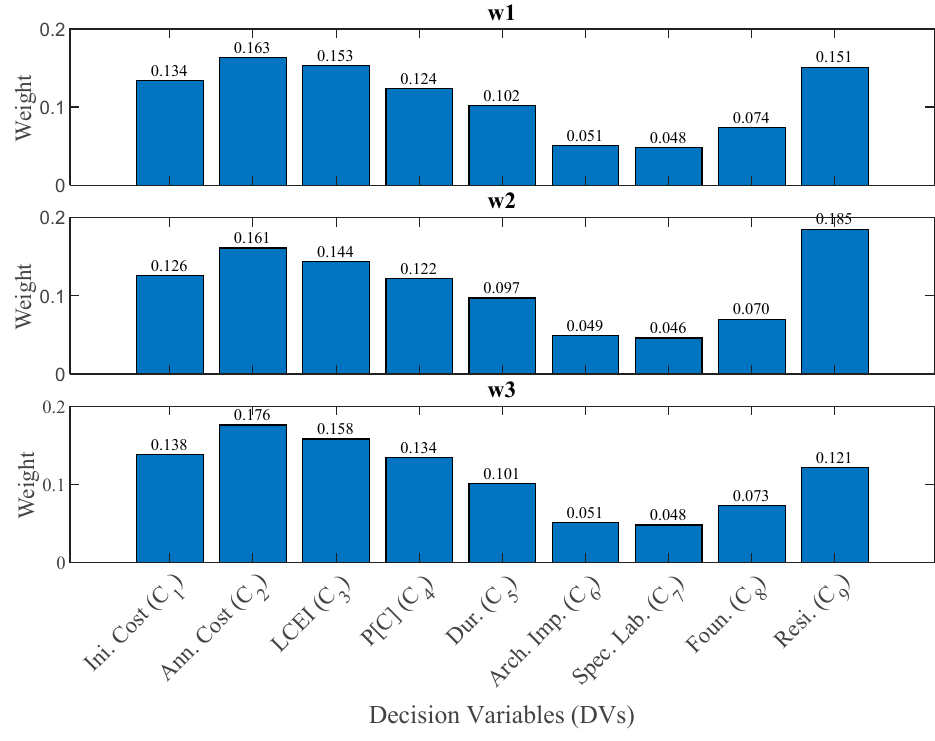
Figure 16. Weight vectors for the MCDM analysis.